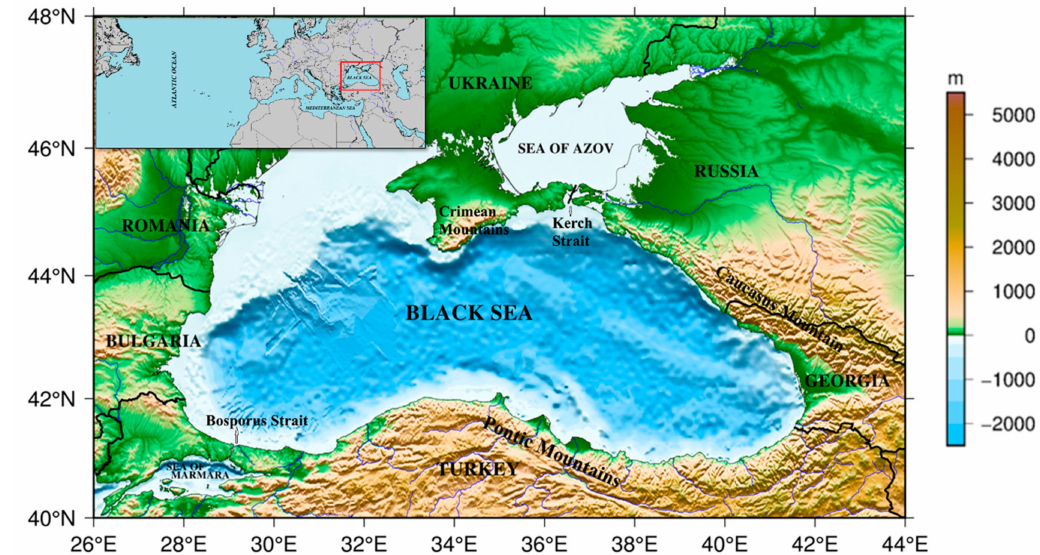
Figure 1. Black Sea with its location. Topographic data were used from the ETOPO1 1 Arc-Minute Global Relief Model bedrock data